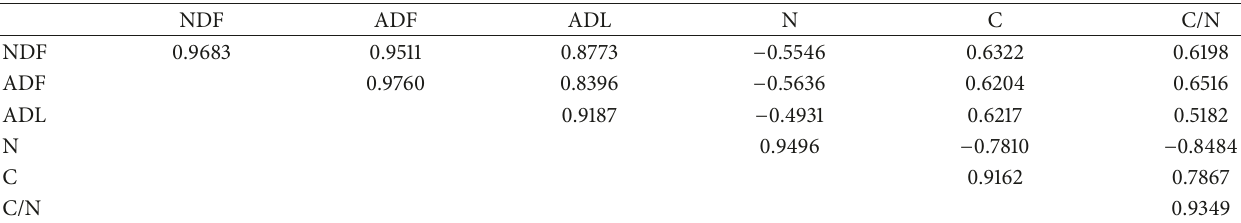
Table 4: Pearson correlation coefficients for canola residue traits measured using laboratory reference methods and compared to NIRS predicted values across all years, locations, plant components, and canola types. For each pair, the level of significance was < 0.0001 at 𝑃 < 0.05 ( 𝑛 = 522 ). NDF ADF ADL N C